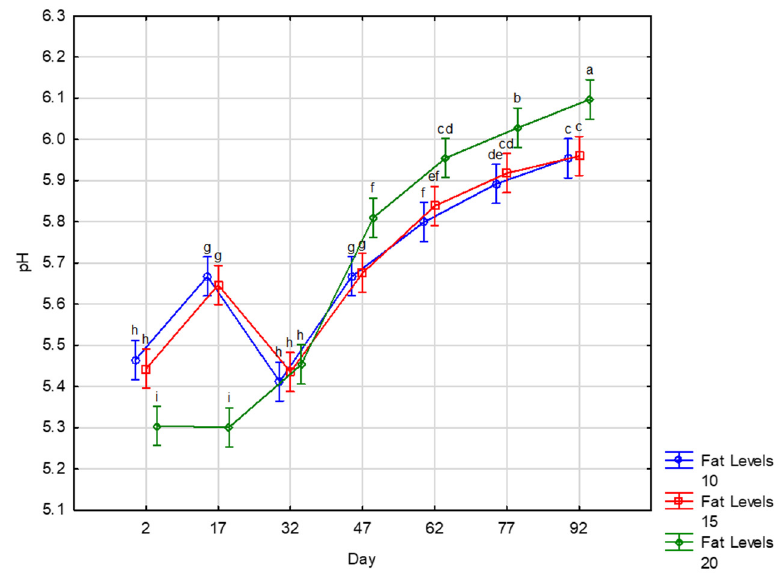
Figure 2. pH of zebra droëwors made with different sheep fat levels during storage. a–h Means with different superscripts differ ( p ≤ 0.001).